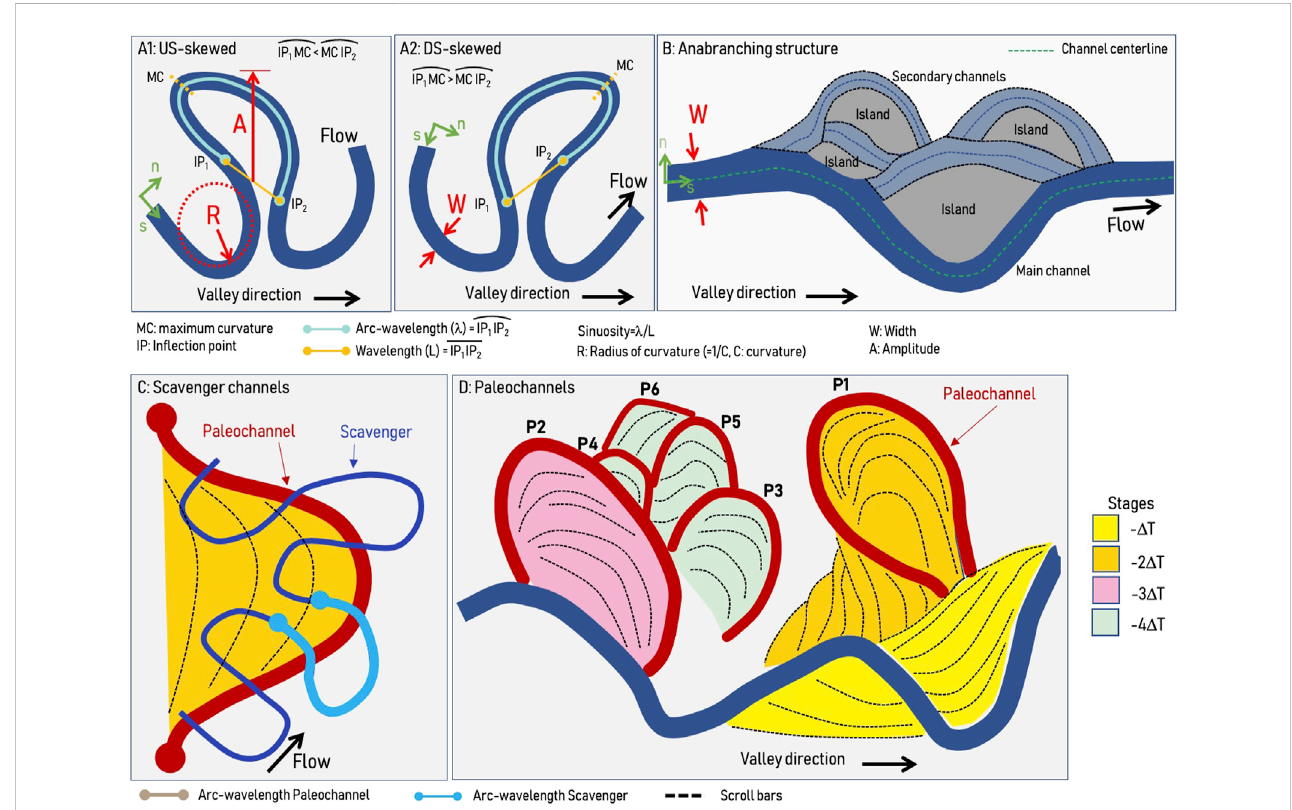
FIGURE 2 (A) meandering river (A1: US-skewed, A2: DS-skewed), (B) Anabranching structure, (C) Under fi t-scavenger channels, (D) Paleochannels in different stages